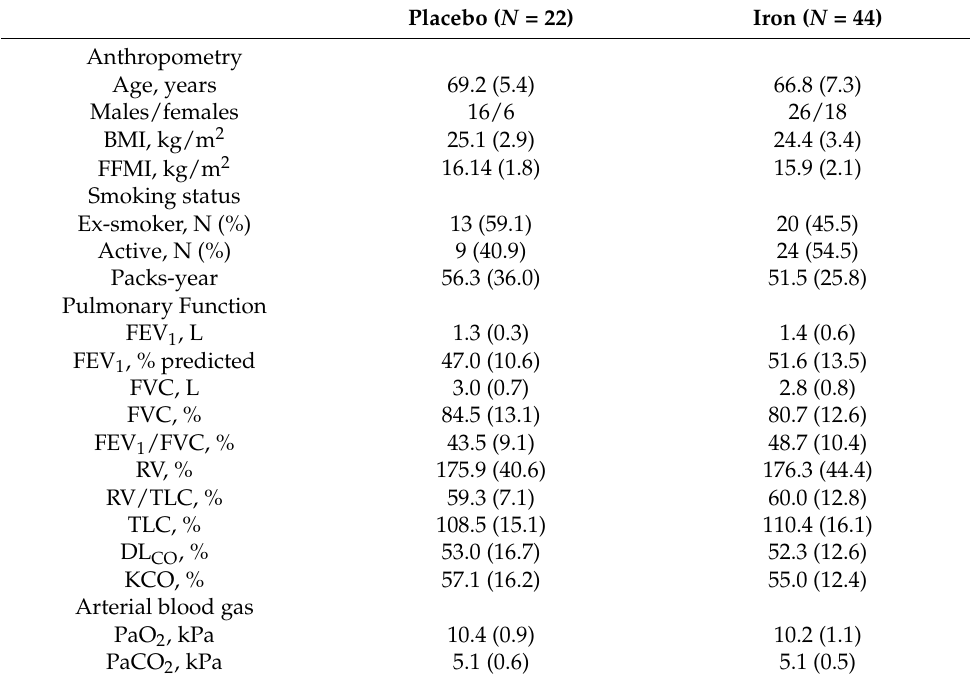
Table 1. Clinical characteristics of the study patients at